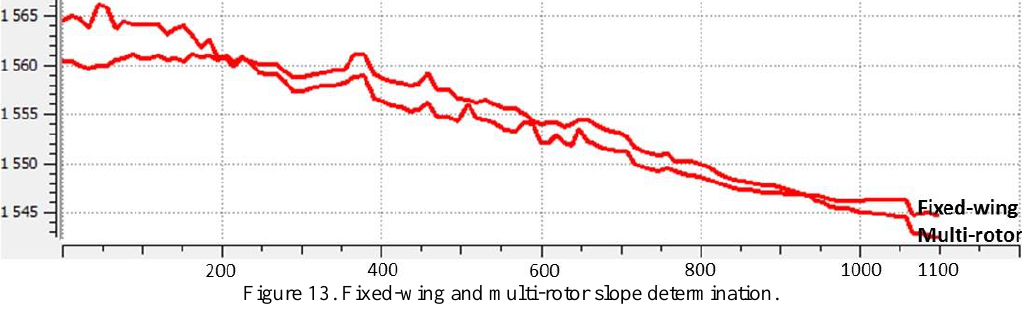
Figure 13. Fixed-wing and multi-rotor slope determination.